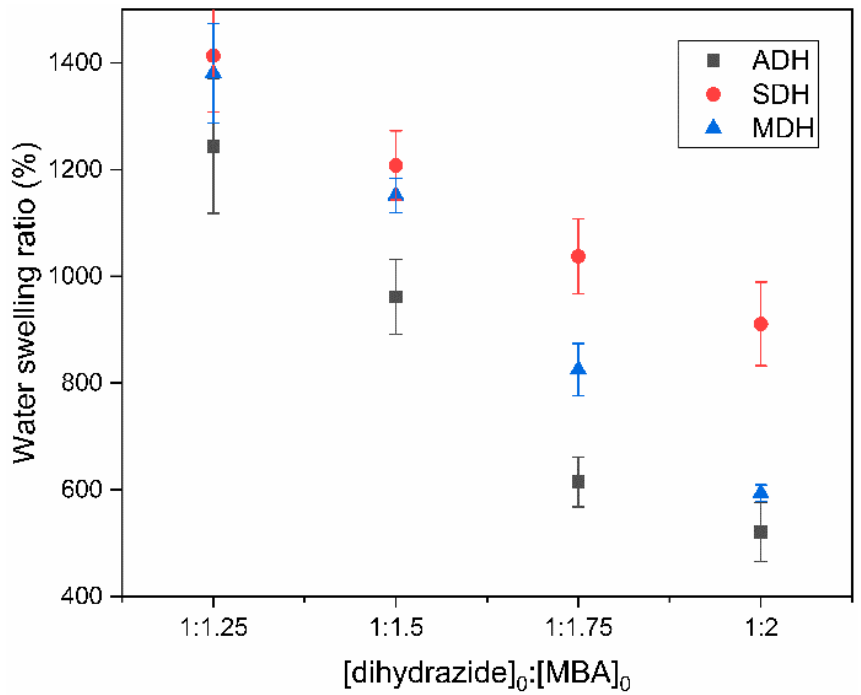
Figure 2. Water-swelling ratio of ADH-PAMHx (black, square), SDH-PAMHx (red, circle), and MDH-PAMHx (blue, triangle).